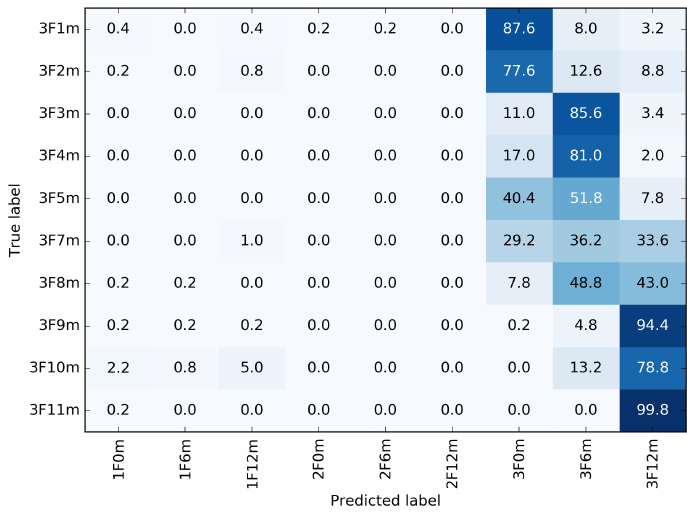
Figure 7. Position classification of the new inter-floor noise dataset into the learned 9 positions